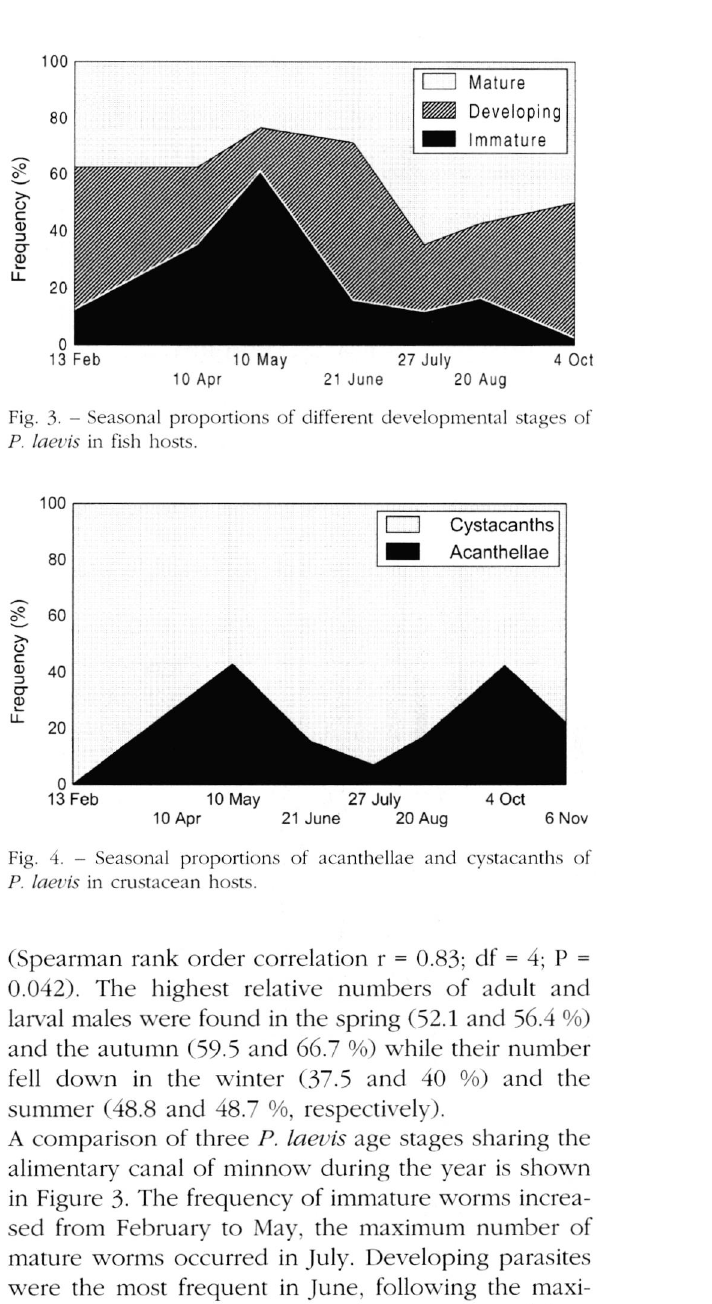
Fig. 1. - Frequency distribution of P. laevis in the final fish hosts.